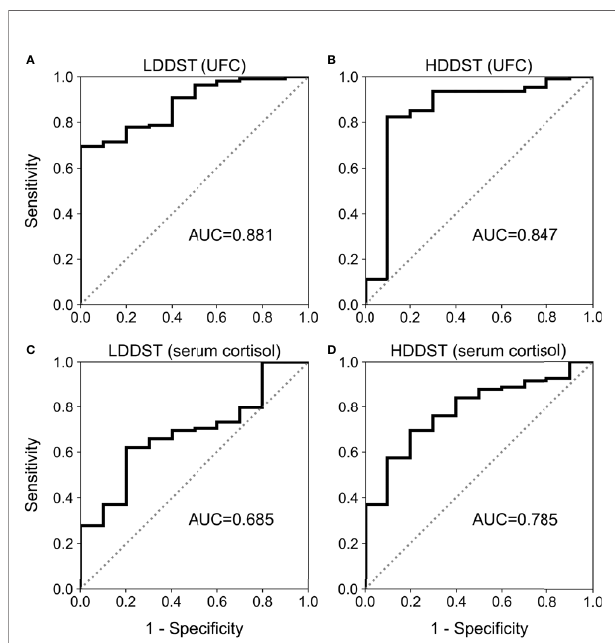
FIGURE 1 | Receiver operating characteristic (ROC) curve for low-dose dexamethasone suppression test (LDDST) or high-dose dexamethasone suppression test (HDDST) using urine-free cortisol (UFC) (A, B) or serum cortisol (C, D) among 108 CD and 10 EAS patients with both serum and urine cortisol measurement during dexamethasone suppression test.